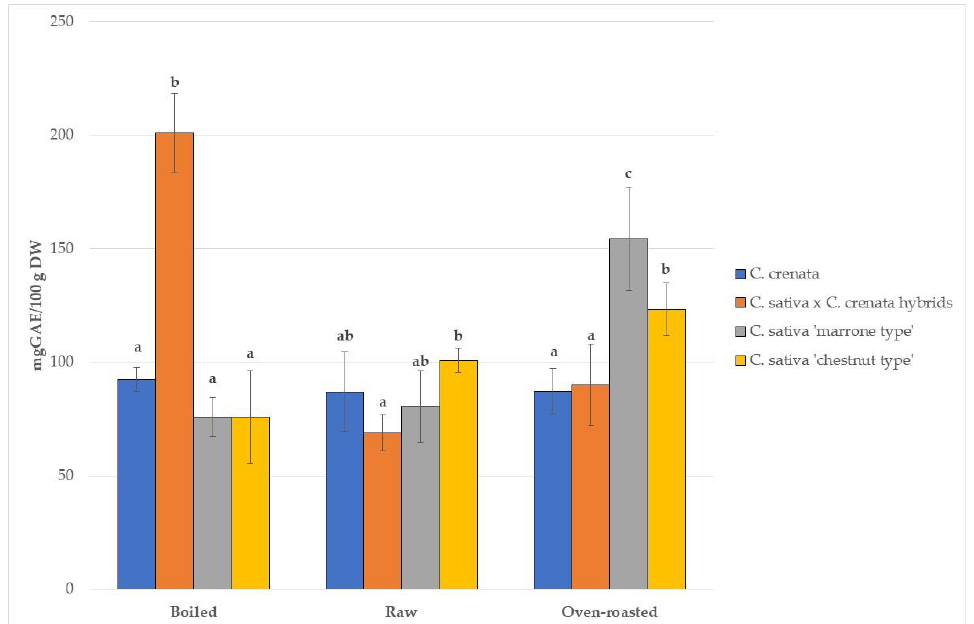
Figure 1. TPCs of all the chestnut groups. Different letters for all the considered groups indicate significant statistical differences ( p < 0.05) among different species/hybrids in the same “cooking method” groups. Different colours represent the considered genotypes.